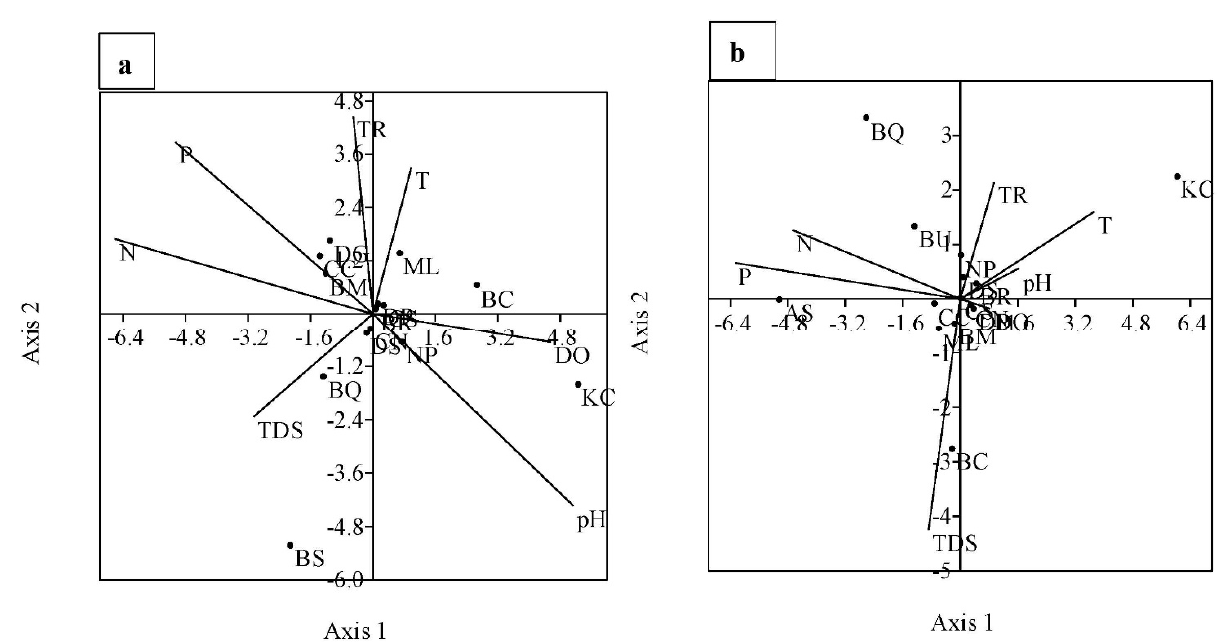
Figure 6. CCA biplot between zooplankton species and ecological parameters ( a ) December and ( b ) February. (T: Temperature, TR: Transparency, N: Nitrates. P: Phosphates, AS: Asplanchna sieboldi